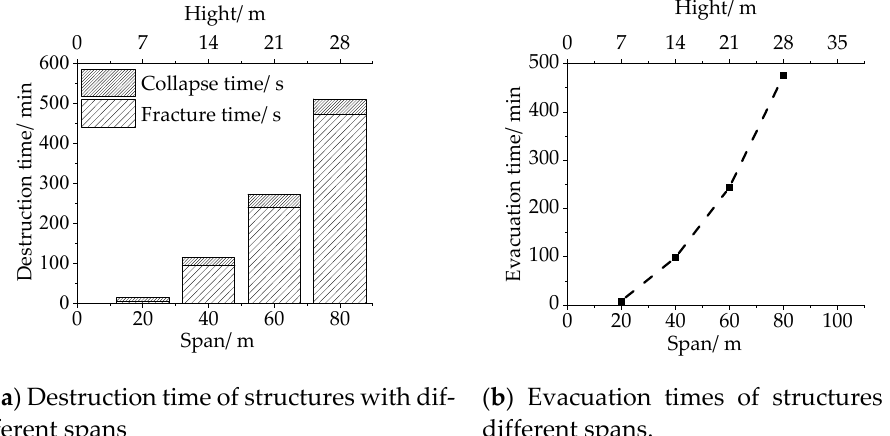
Figure 24. Destruction and evacuation times of different